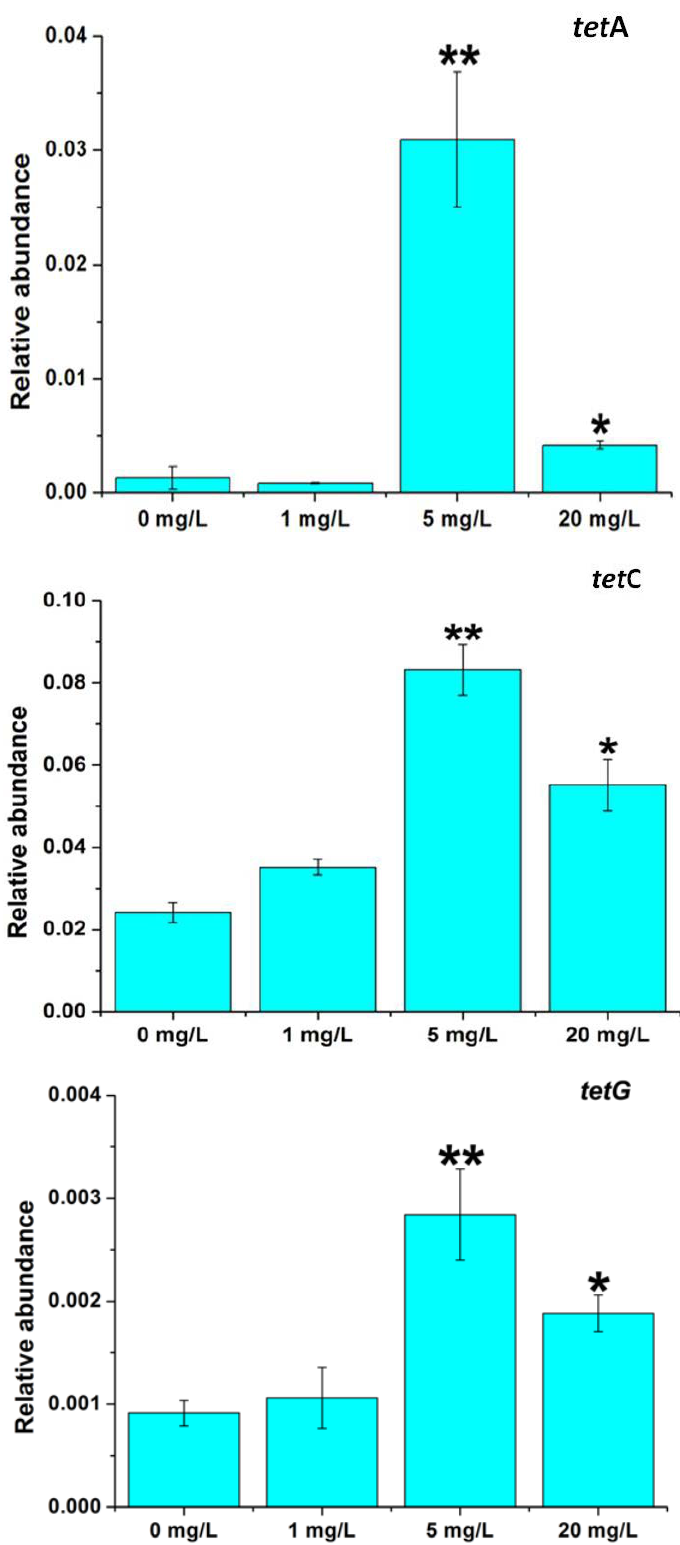
Figure 5. Relative abundance of tetA , tetC and tetG in sludge fed with different concentrations of tetracycline for 6 days. qPCR was used to determine the relative abundance normalized to the total copy number of 16S rRNA genes in corresponding samples. ** p < 0.01, comparing 5 mg/L with 0 mg/L; * p < 0.05, comparing 20 mg/L with 0